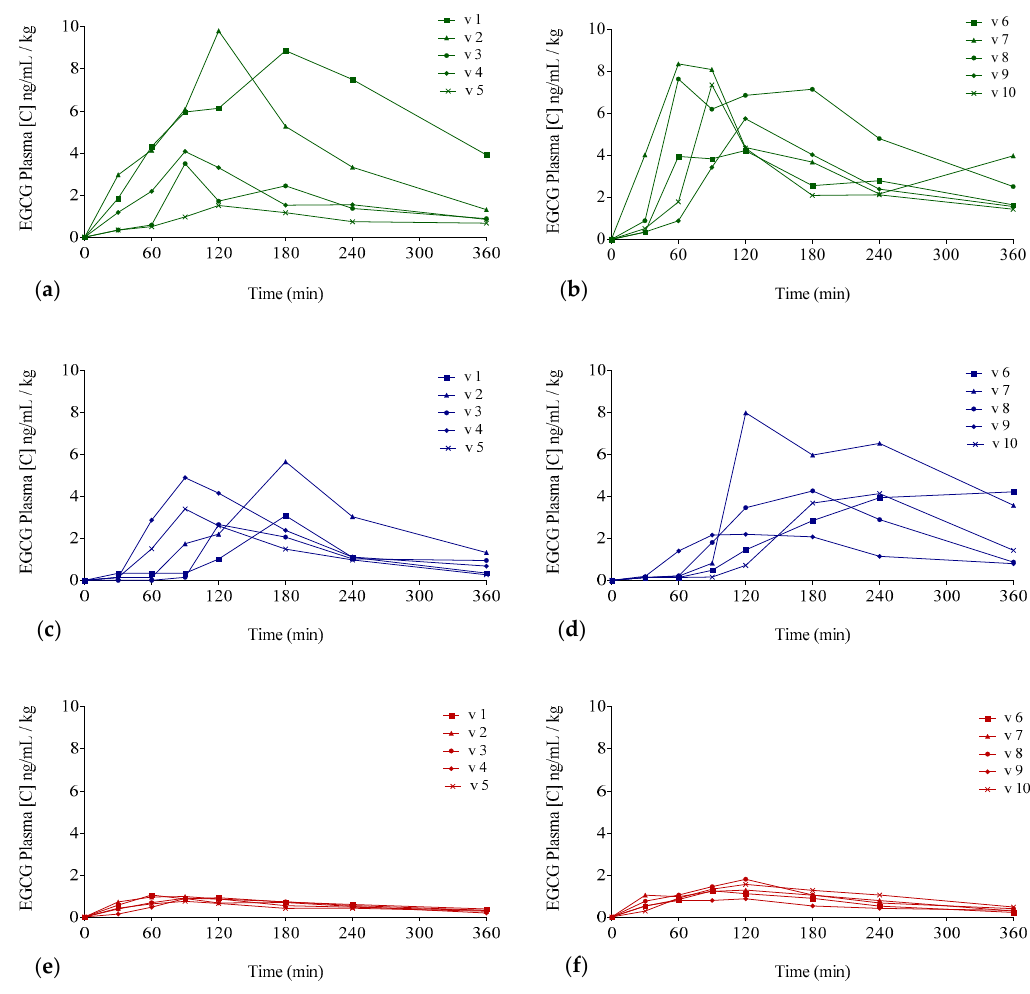
Figure 3. Plasma EGCG concentration–time curves for each of the participants for the three different EGCG preparations: Concentrations for men ( a , c , e ) and ( b , d , f ) for women. Teavigo ® condition is shown by green lines ( a , b ), Teavigo ® plus breakfast is shown by blue lines ( c , d ), and FontUp ® is shown by red lines ( e , f ).